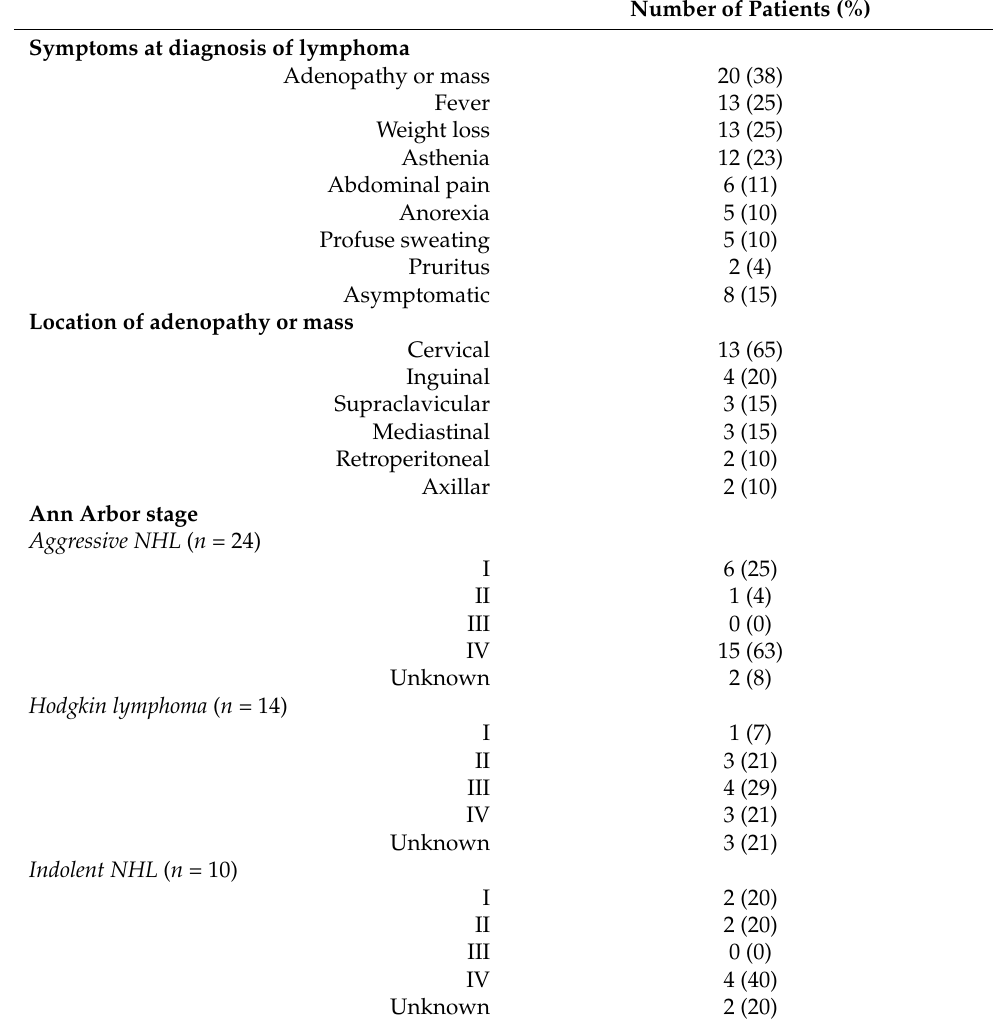
Table 3. Characteristics of the patients at diagnosis of lymphoma. NHL: Non-Hodgkin